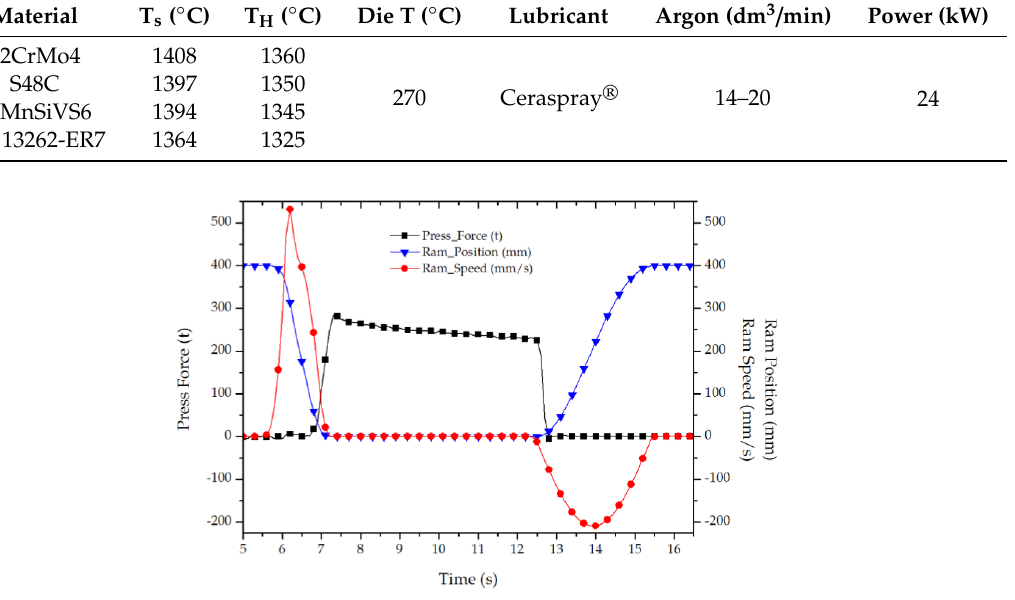
Figure 3. Example of the press force, ram position, and ram speed during the NSF process.